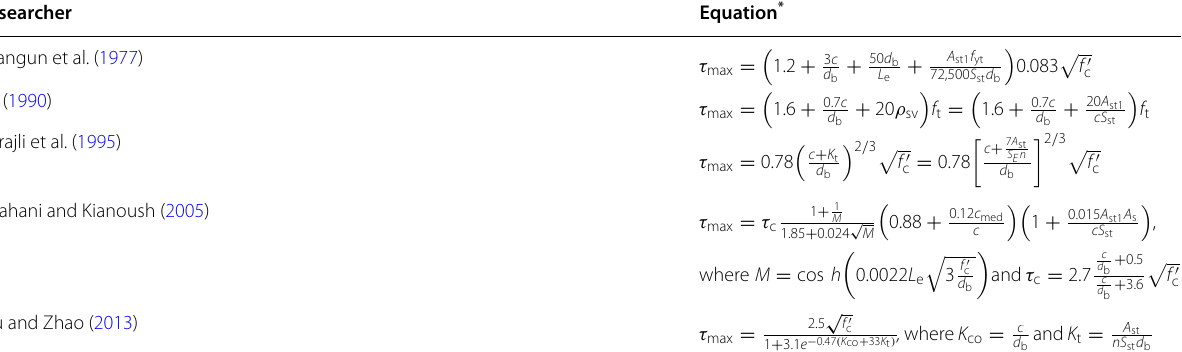
* A s : cross-sectional area of one longitudinal reinforcement (mm 2 ), A st : cross-sectional area of all legs of transverse reinforcement (mm 2 ), A st1 : cross-sectional area of one leg of transverse reinforcement (mm 2 ), L e : embedded length (mm), S st : spacing of transverse reinforcement (mm), c : minimum of spacing and cover thickness (mm), c med : median of side cover, bottom cover, and rebar spacing, d b : diameter of rebar (mm), f t : tensile strength of concrete (MPa), f ′ c : compressive strength of concrete (MPa), f yt : yield strength of transverse reinforcement (MPa), n : number of tension bars enclosed by stirrups, s : slip of rebar (mm), τ max : maximum bond stress (MPa).